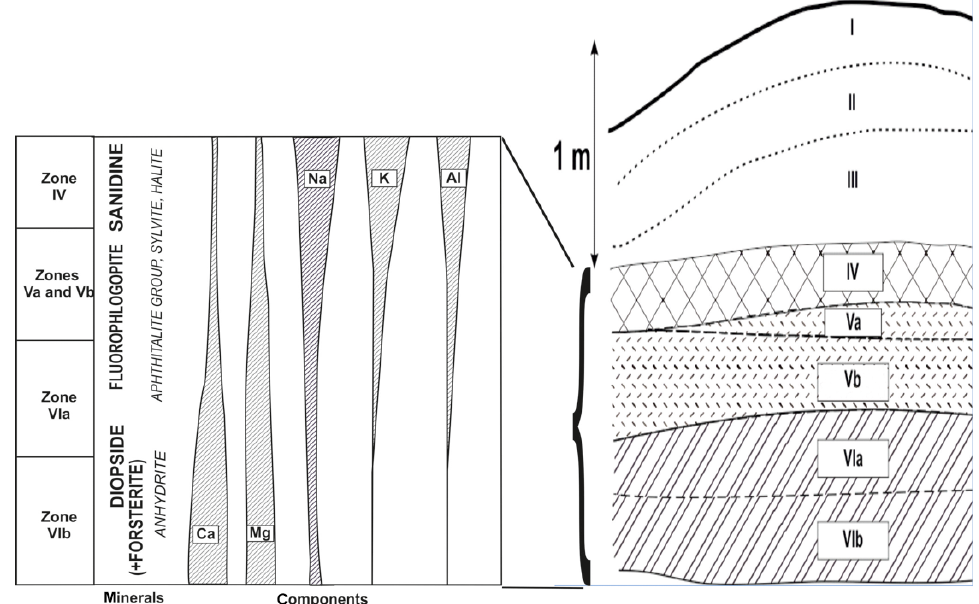
Figure 9. Distribution of the main mineral-forming lithophile metals in the zones of the Arsenatnaya fumarole containing silicate mineral- ization.